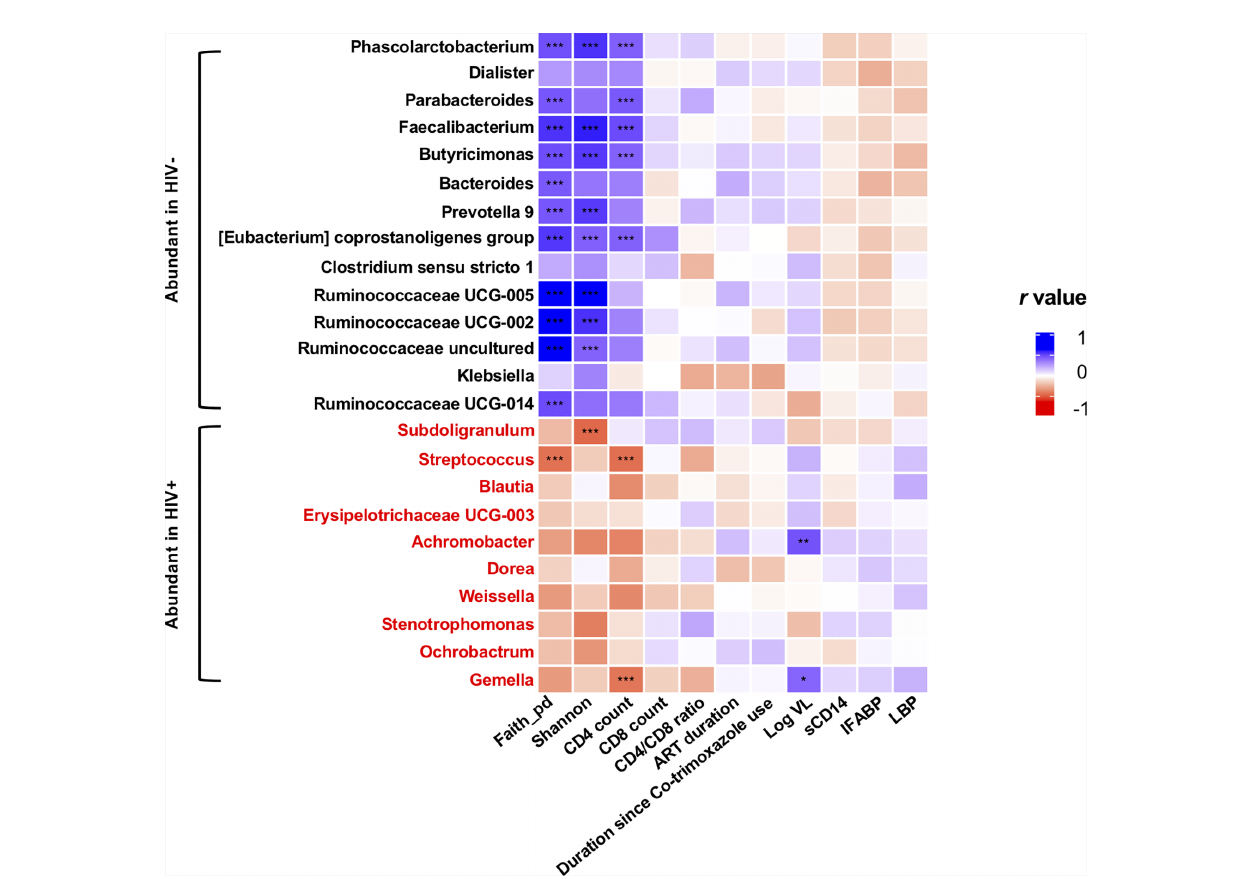
FIGURE 7 | Analyses of correlation of genera showing signi fi cant difference in abundance in HIV- and HIV+ with clinical and immunological markers and microbiome diversities. Faith_pd, Faith ’ s phylogenetic diversity (n = 110); shannon, Shannon ’ s index (n = 110); CD4 count (n = 55); CD8 count (n = 55); CD4_CD8_ratio (n = 55); ART_duration, duration under ART (n = 52); Duration since Co-trimoxazole use (n = 54); Log VL, viral load (> 20 copies/ml) (n = 36); sCD14, plasma soluble CD14 levels (n = 110); IFABP, plasma intestinal fatty acid-binding protein levels (n = 110); LBP, plasma lipopolysaccharide binding protein levels (n = 110). Asterisks indicate signi fi cant correlation determined by Spearman ’ s test; *, **, and *** indicate signi fi cant differences with p < 0.05, p < 0.01, and p < 0.005, respectively. Signi fi cantly abundant genera were determined by ANCOM and LEfSE. Genera signi fi cantly abundant in HIV+ are shown by